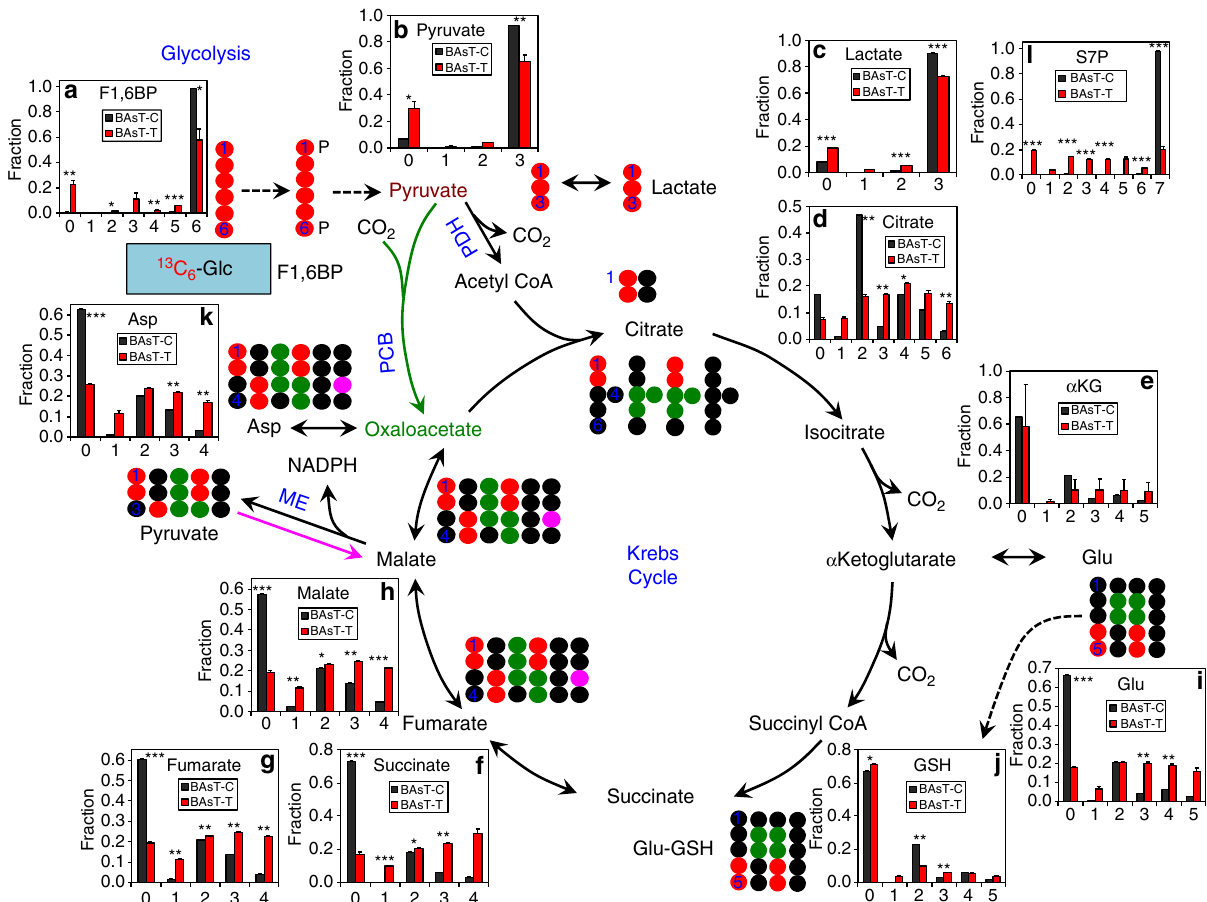
Fig. 5 Central metabolic activity of arsenite-transformed BAsT cells is sensitive to the tumor microenvironment. Human bronchial alveolar BEAS2B cells were transformed by exposure to 1 µ M Na 2 AsO 3 for 18 weeks before subcutaneous xenograft of the transformed cells (BAsT cells) into NSG mice. After 4 months, mice were fed the 13 C 6 -Glc enriched liquid diet for 18 h (cf. Fig. 1) before necropsy. Tumor tissues were processed and analyzed by IC-UHR- FTMS as described in Fig. 3. A 13 C 6 -Glc tracer experiment was also performed for the BAsT cells as in vitro culture for 24 h in DMEM before extraction for polar metabolites, followed by IC-UHR-FTMS analysis ( n = 3). Shown in a – c , d – k , and l are the fractional enrichments in the isotopologues of metabolites derived from glycolysis, the Krebs cycle, and the PPP, respectively. F1,6BP: fructose-1,6-bisphosphate; S7P: sedoheptulose-7-phosphate; BAsT-C (black square): in vitro cell cultures; BAsT-T (red square): tumor xenografts; all other abbreviations are as in Fig. 3. The x -axis represents the number of 13 C atoms present in each compound. Values shown were mean ± SEM ( n = 3). * 0.01 < P < 0.05; ** 0.001 < P < 0.01; *** P < 0.001, two-tailed t -test (see